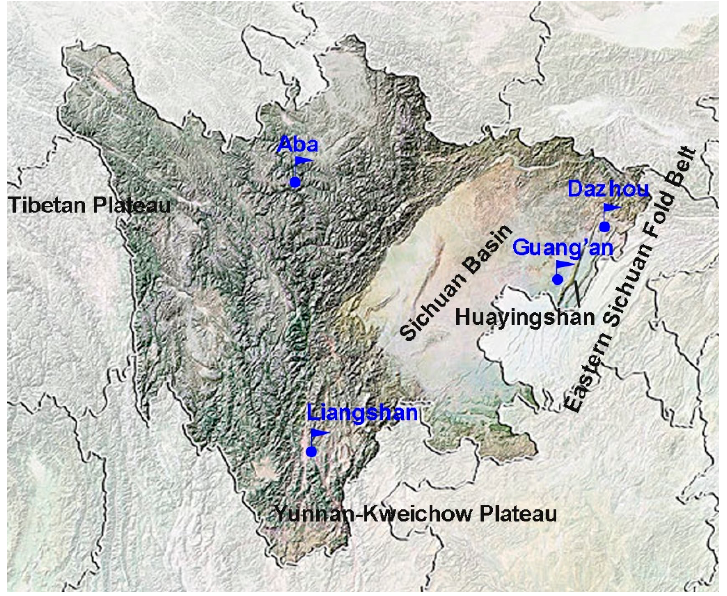
Figure 1. Sampling distribution of the four Qu from different geographical areas in the rim of the Sichuan Basin.